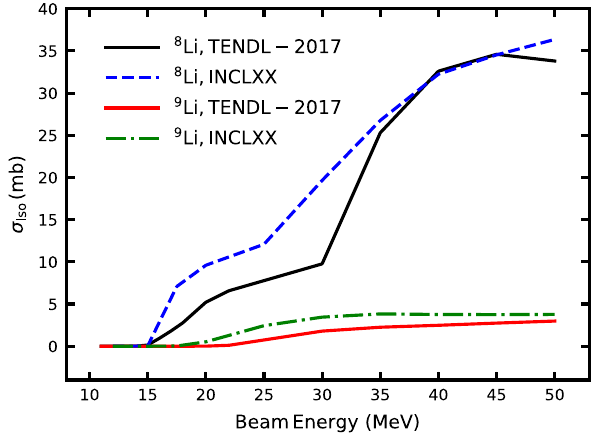
Fig. 1 ComparsionbetweentheINCL ++ simulationandtheTENDL- 2017 Nuclear data library [60] for the production cross section of 8 Li and 9 Li in low energy deuteron-beryllium reactions